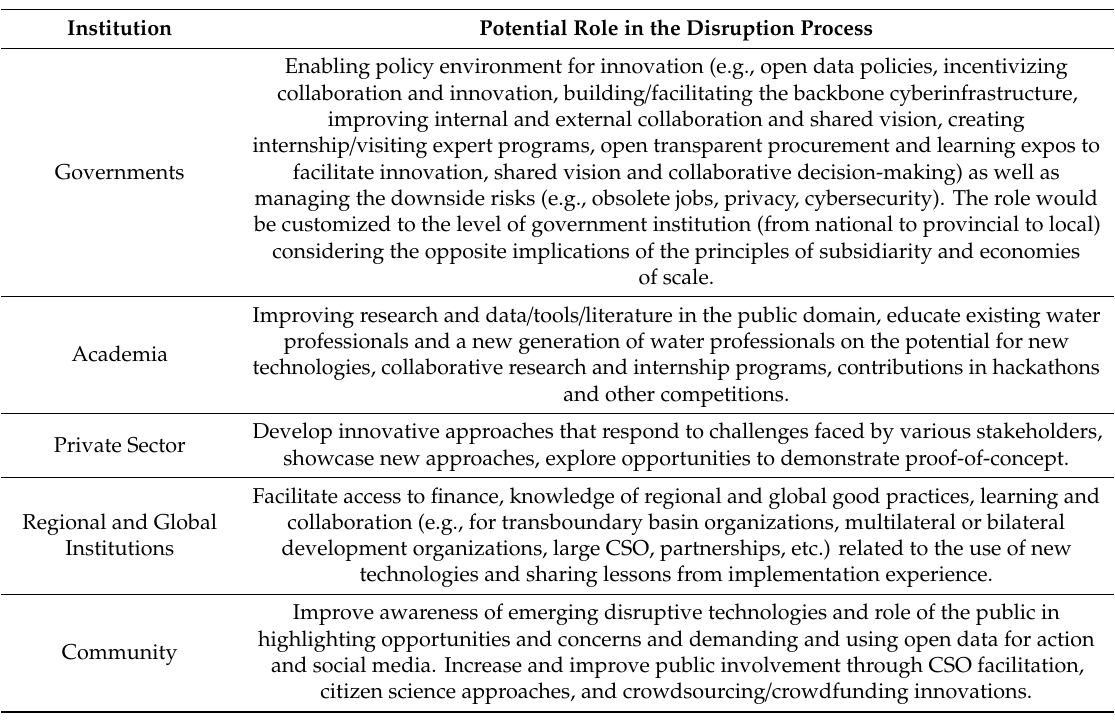
Table 2. Institutional roles in the disruption